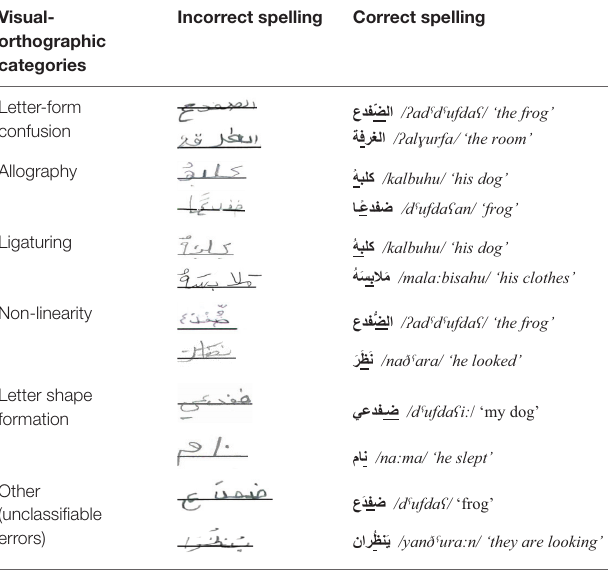
TABLE 1 | Examples of spelling errors from the six visual-orthographic categories.